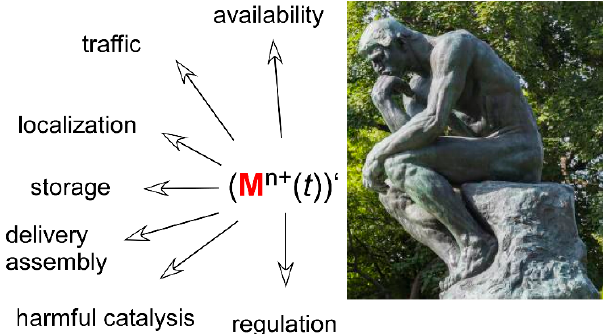
Figure 5. Transition metals in biology: a bonanza for coordination chemistry. ()’ stands for the derivative (Lagrange) notation with t being the time. The figure indicates some of the areas in which transition metal binding and exchange are, and will continue to be, studied. The picture is taken from http://www.musee-rodin.fr/fr/collections/sculptures/le-penseur.